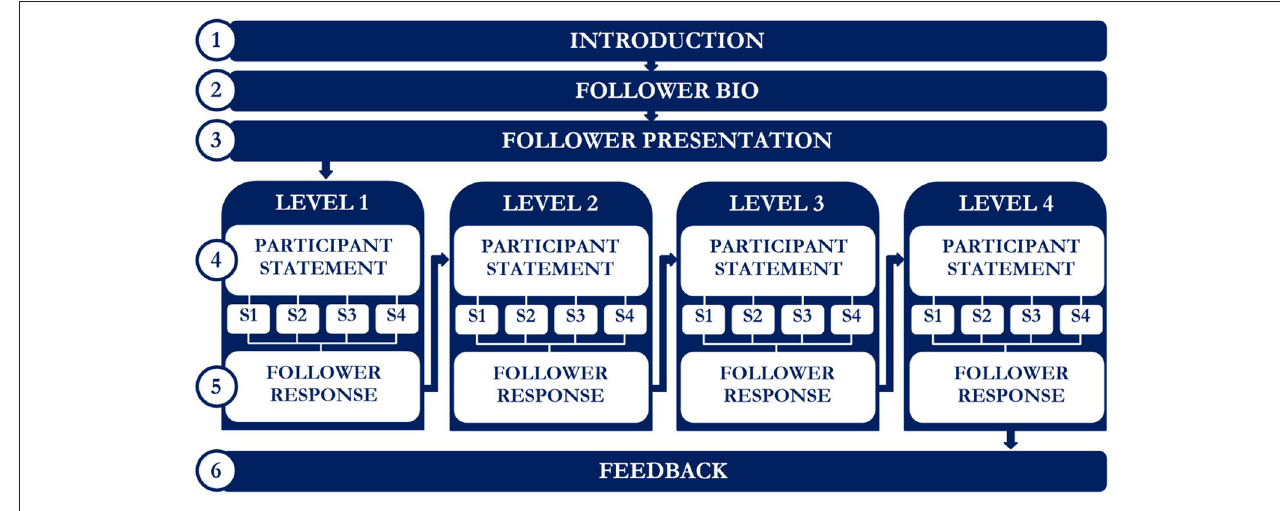
FIGURE 2 | Scenario structural